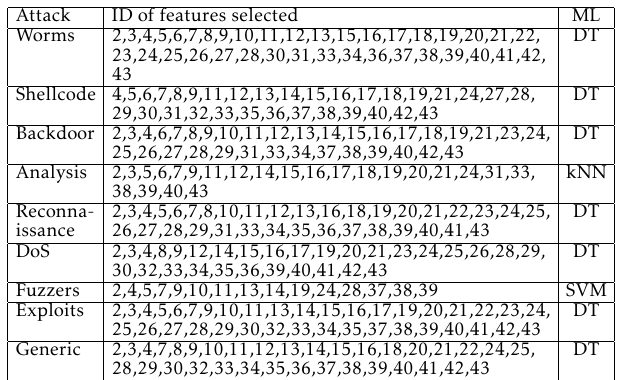
Table 40. Results of feature reducing with each attack type using BFE